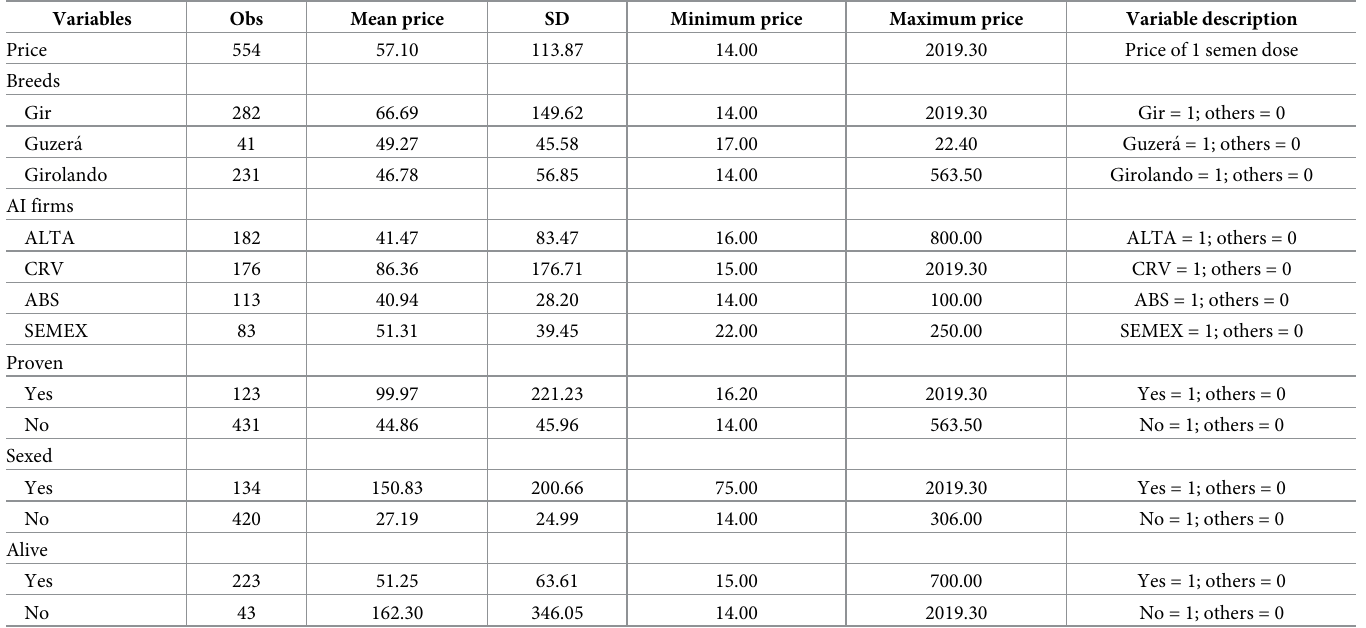
Table 1. Statistics and description of the variables collected on bovine semen (price in R$ /dose of semen). Variables